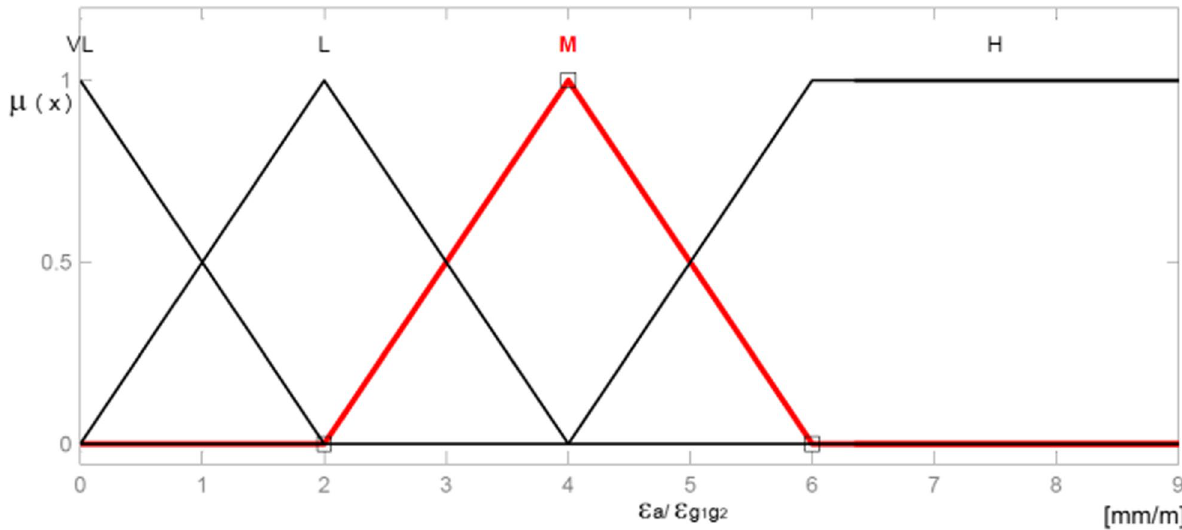
Fig. 3 Membership functions for model variables, directional and principal horizontal